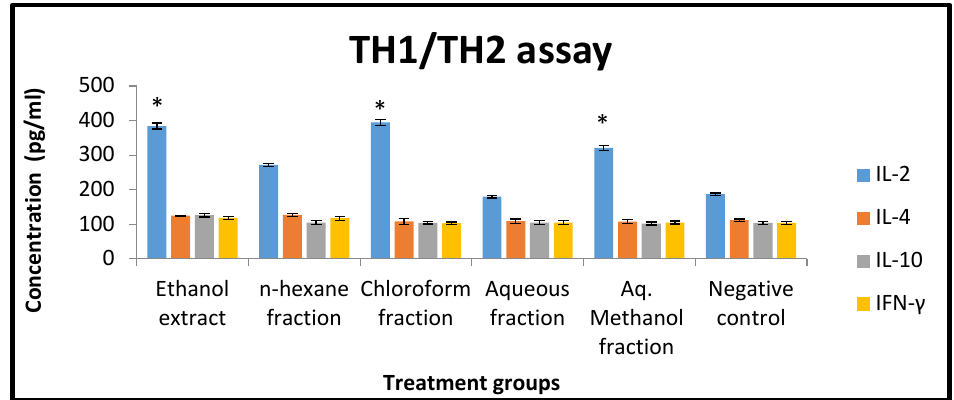
Figure 9. The effect of X. spinosum extract and fractions (at a concentration of 1mg mL − 1 ) on the expression level of different cytokines (pg mL − 1 ). Results are expressed as means of three independent experiments (bars) ± SEM (lines). (* p < 0.05)). Treated groups are compared to the negative control.